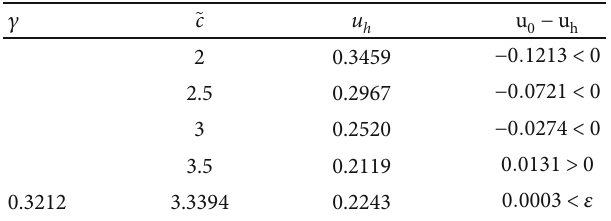
Table 5: Results obtained by using the multigrid method with ε = 10 − 3 precision and the step length δ = 0 : 5 for Case 1.